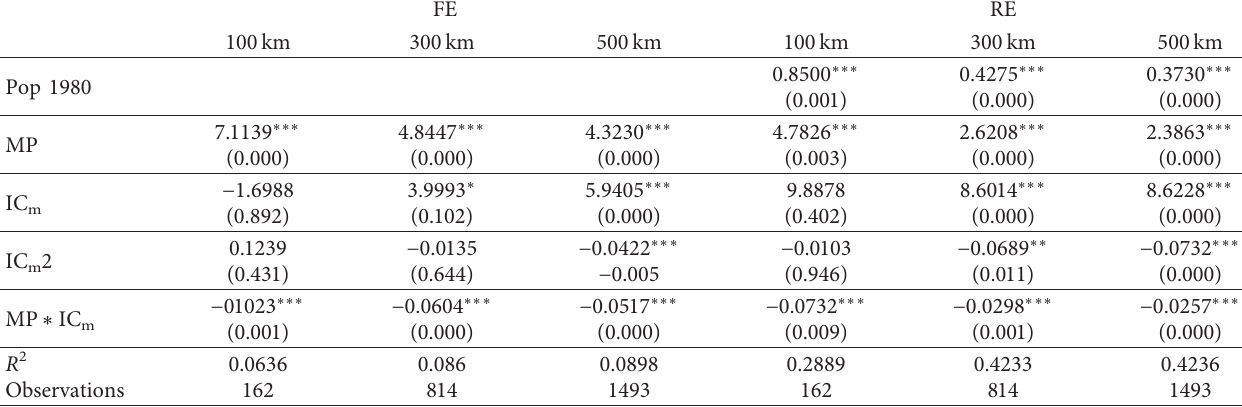
Table 7: Regression results of service share within 100km, 300km, and 500km, 5-year